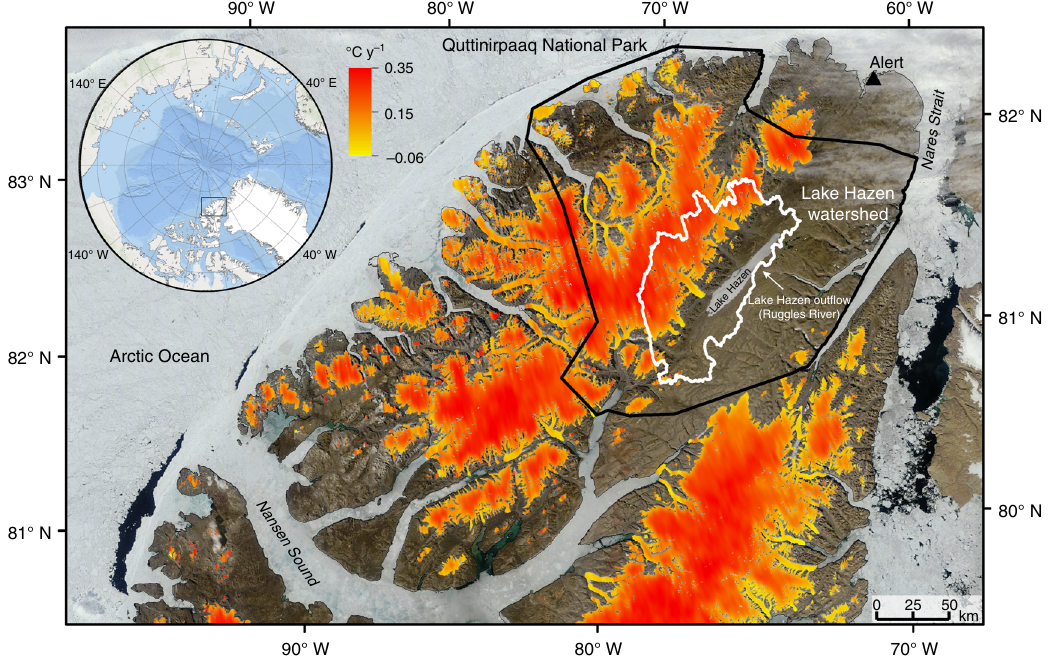
Fig. 1 Location of the Lake Hazen watershed and changes in glacier surface temperatures. Changes in summer glacier surface temperatures (°C y − 1 ) were quanti fi ed for the months of June, July and August for the period 2000 – 2012. The white line delineates the boundaries of the Lake Hazen watershed, and the glaciers within it (northern Ellesmere Island, Nunavut, Canada). The catchment area to lake area ratio for Lake Hazen is 12.7. The black line delineates the boundary of Quttinirpaaq National Park, Canada ’ s most northerly national